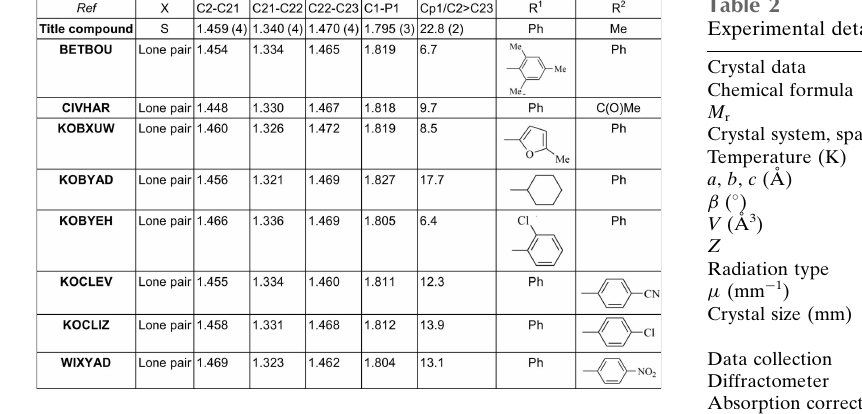
Figure 5 Comparison of bond distances (A˚ ) and dihedral angles between the substituted Cp ring (Cp1) and the vinyl mean plane ( (cid:4) ) for closely related compounds (CIVHAR: Stepnicka et al. , 2008; BETBOU: Kehr et al. , 2017; KOB***: Schaarschmidt et al. , 2014; WIXYAD: Iftime et al. ,